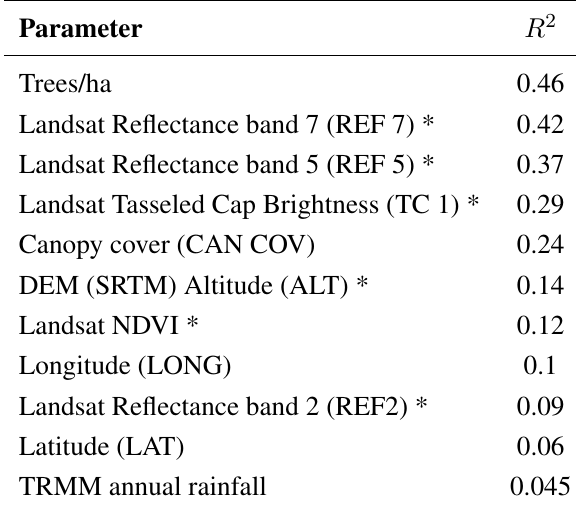
Table A2. All remote sensing parameters fitted over the NMDS ordination are listed in this table. Parameters marked with * have been used for Random Forest modeling.